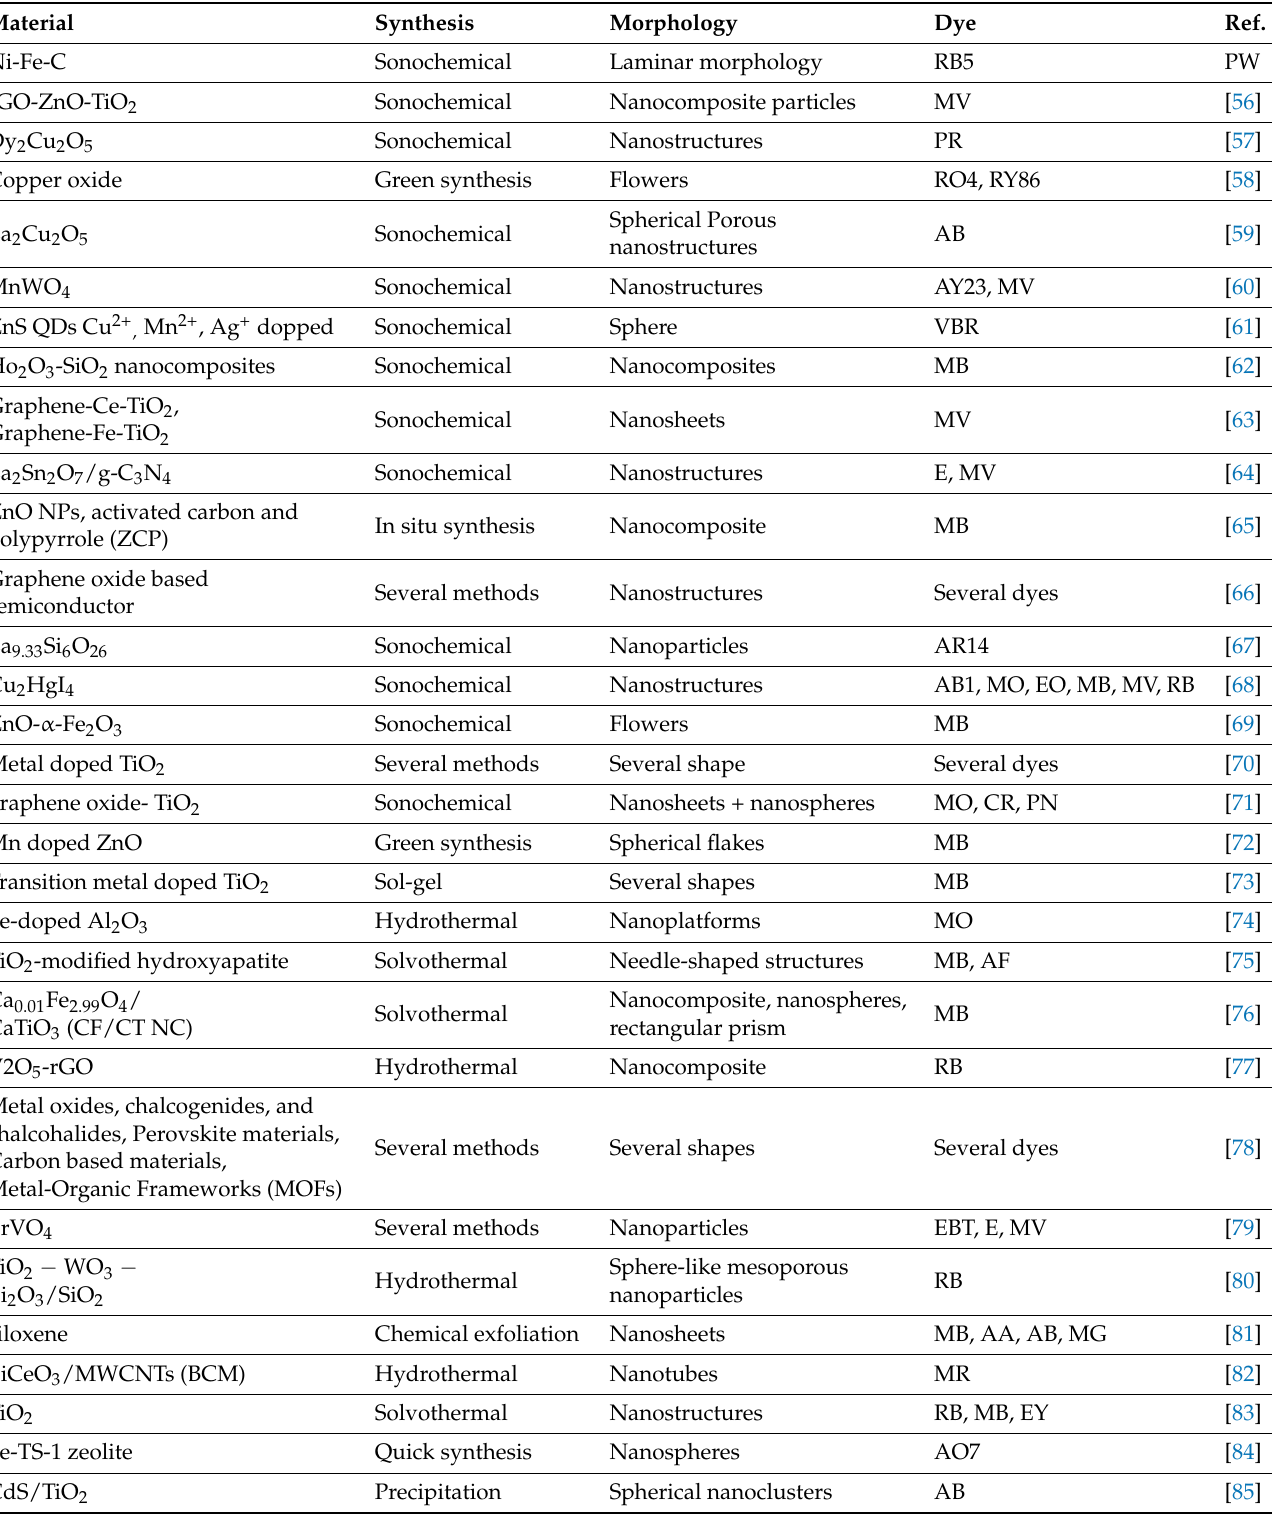
Table 1. Dye decolorization with photocatalytic